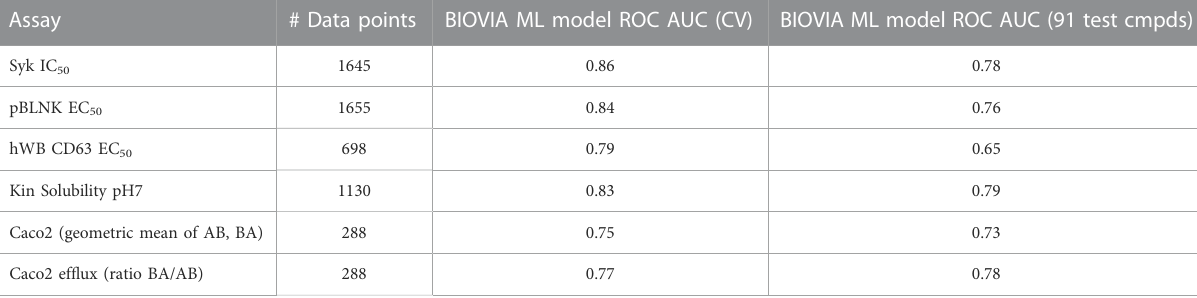
TABLE 2 Statistics for 2D